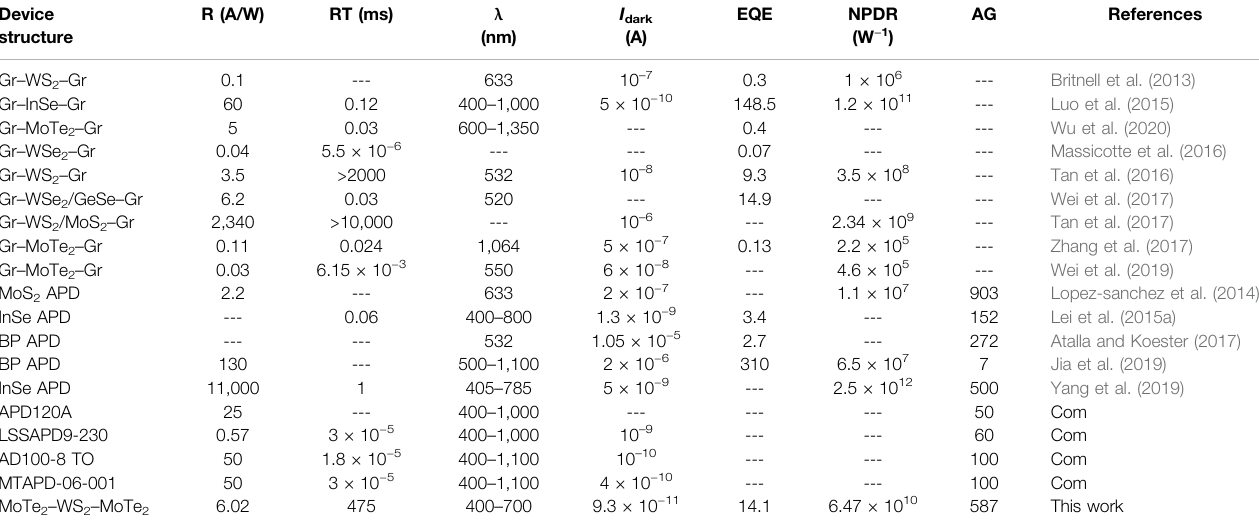
TABLE 1 | Comparison of device performances. Device